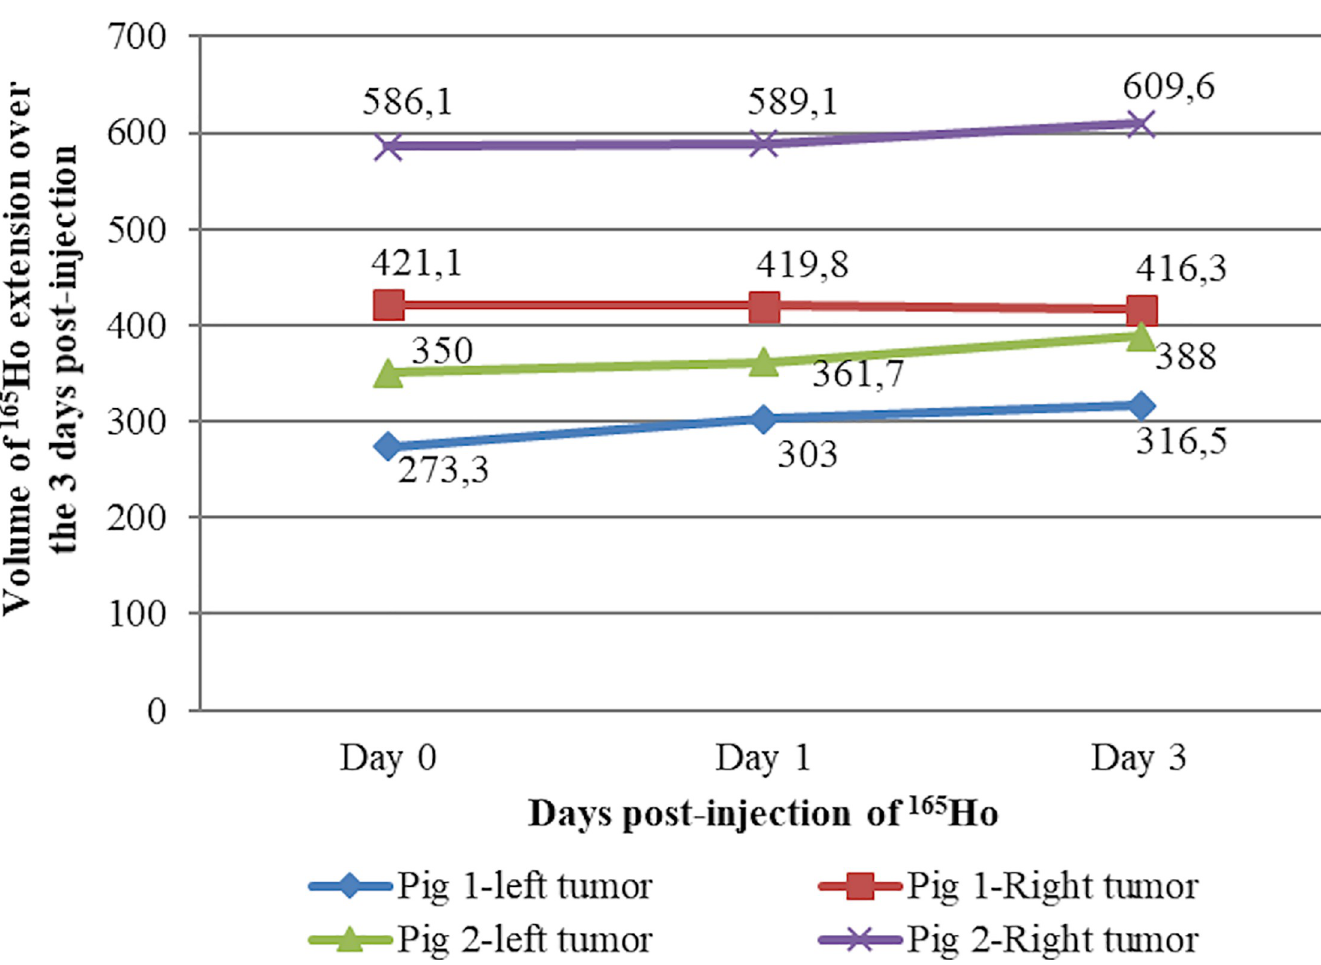
Fig 5. Volume (mm 3 ) of distributed Ho over the 3 days post-injection (pigs n˚1 and 2). Based on CT-acquisitions performed at days 0, 1 and 3 post-injection.